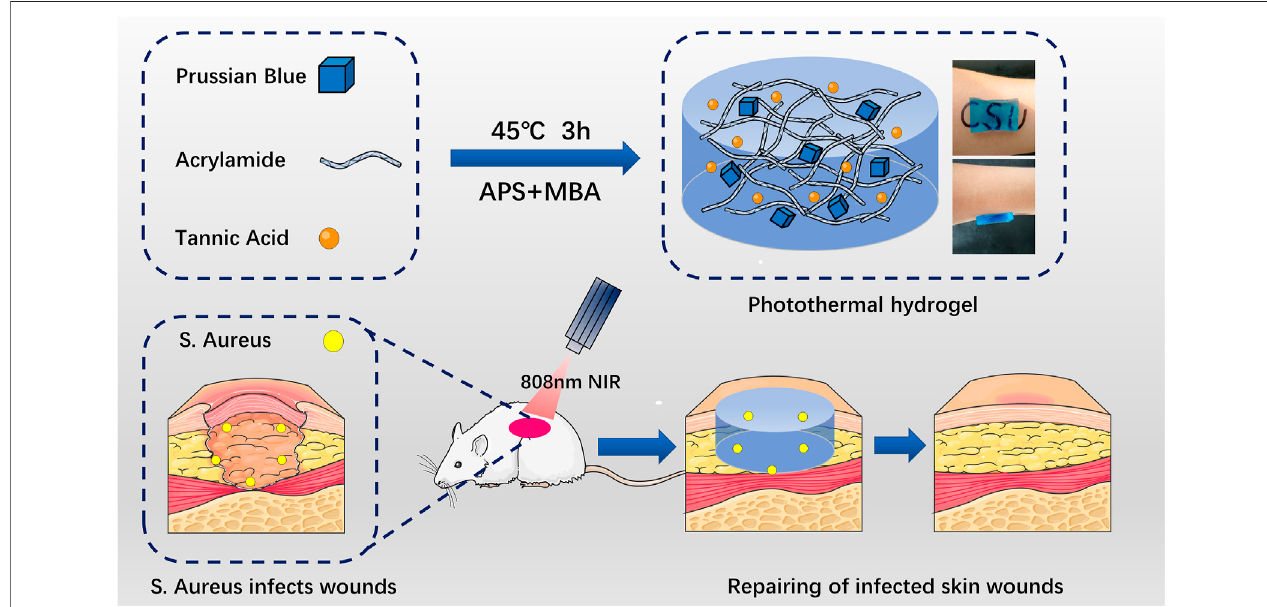
FIGURE 1 | Schematic diagram of Prussian blue nanoparticles and tannic acid drug particles loaded on acrylamide hydrogel for the elimination of bacteria and promotion of skin repair through the synergistic photothermal and antibacterial action of the drugs. APS: ammonium persulfate. MBA: 4-sulfanylbutanimidamide.